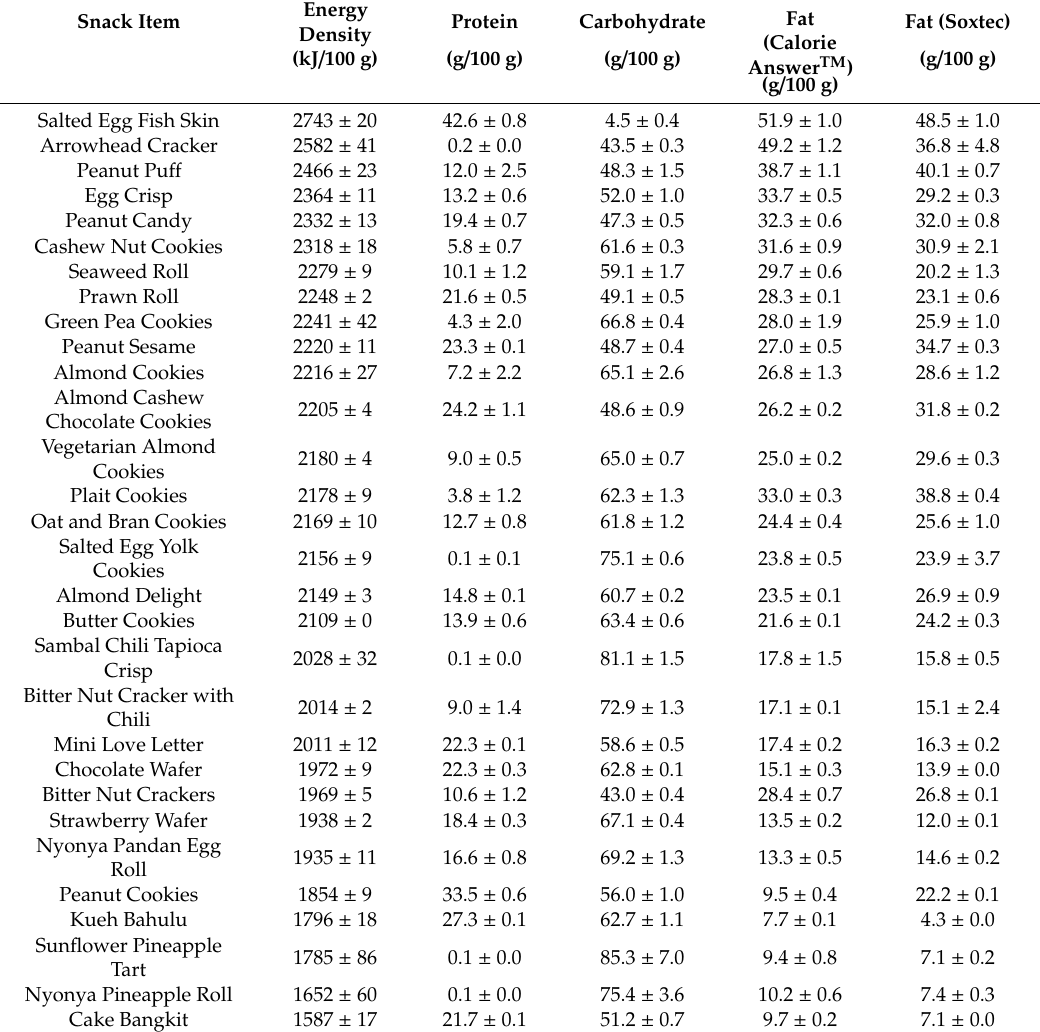
Table 1. Energy density and macronutrients contents of the commonly consumed CNY snacks. Values are expressed as mean ±